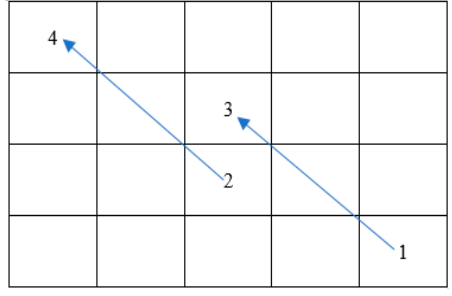
Figure 6. Potential field method misalignment principle.